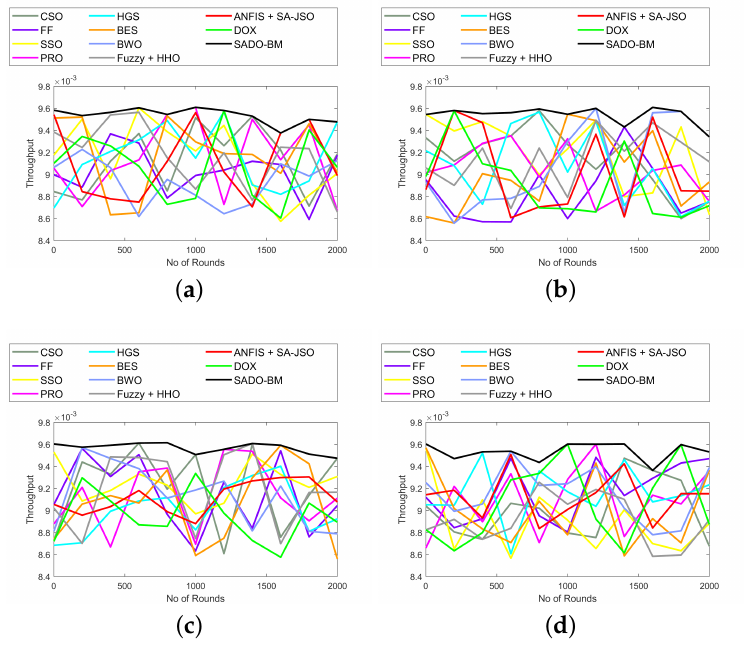
Figure 9. Throughput analysis of SADO-BM over other models for node counts ( a ) 100, ( b ) 250 ( c ) 750, and ( d )